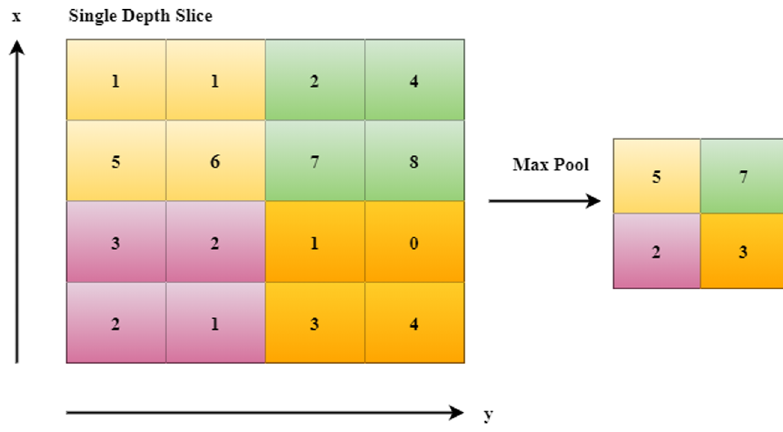
Figure 6: Max - pooling